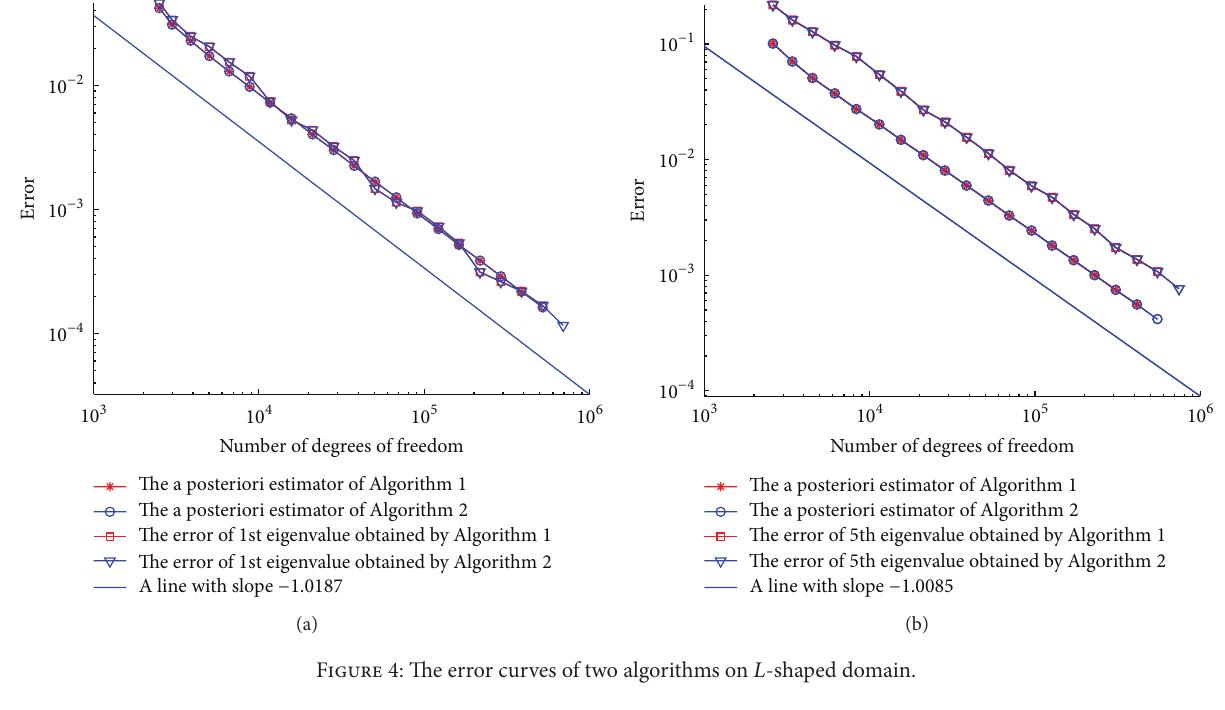
Figure 4: The error curves of two algorithms on 𝐿 -shaped